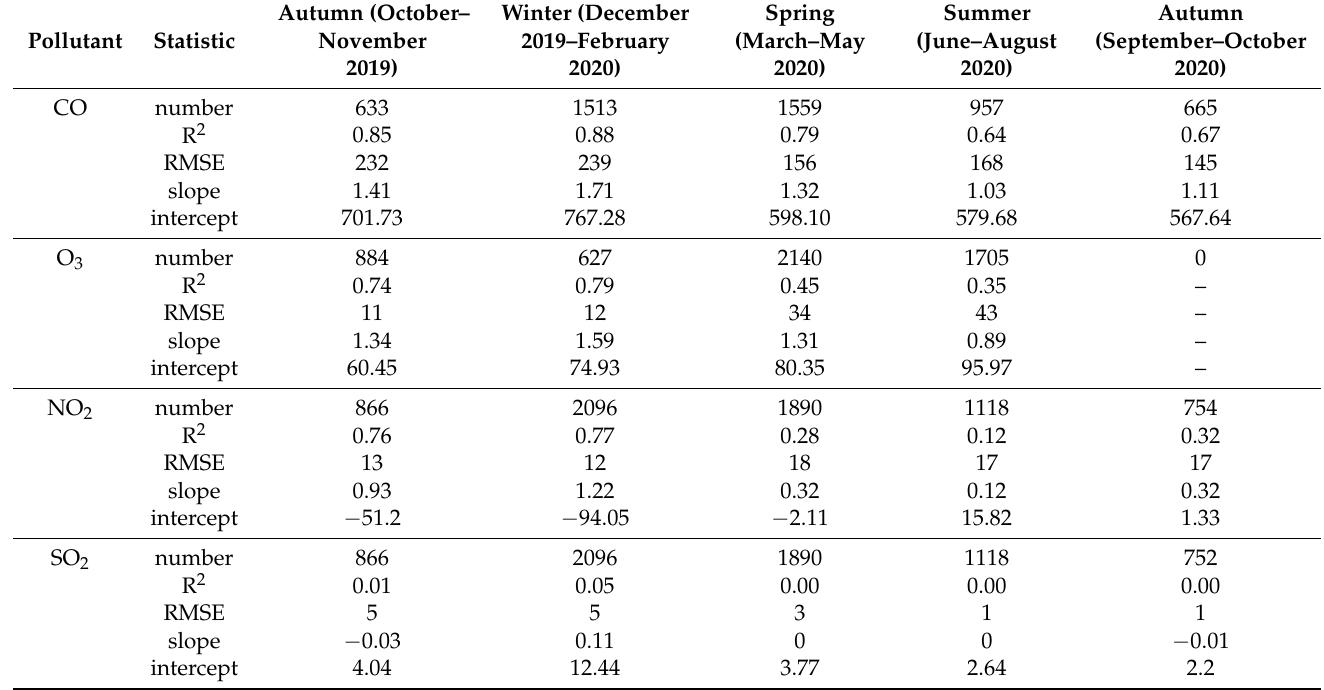
Table 2. Seasonal changes in the stability and biases of four sensors in one model after